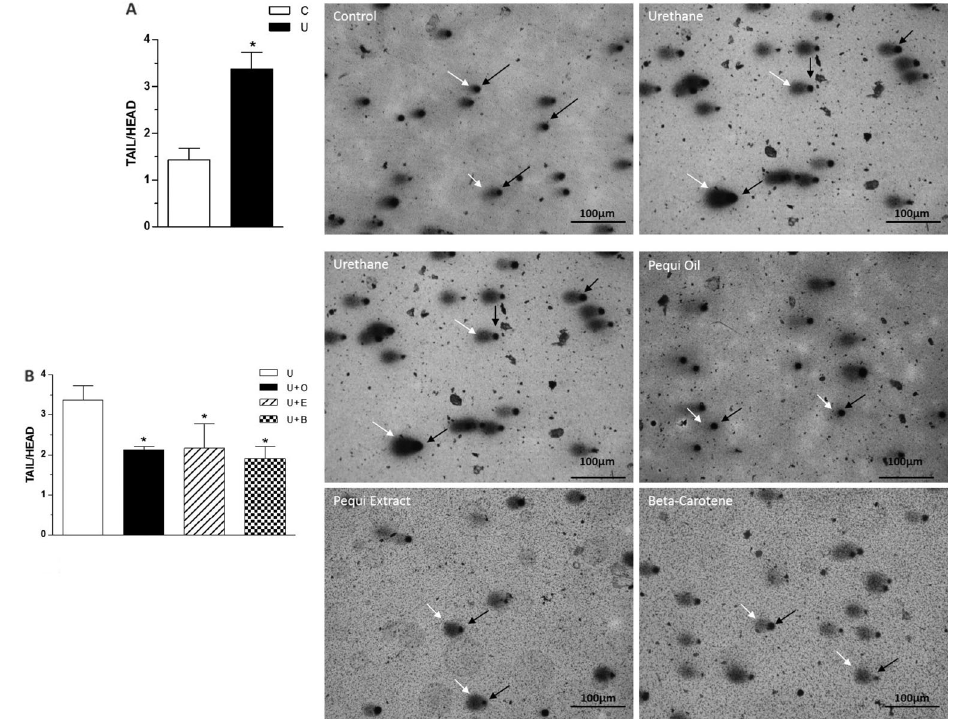
Figure 4. Oxidative damage to DNA in lung tissue specimens. A , Lung tissues from urethane-injected mice (U) showed higher DNA damage when compared to control mice (*P o 0.0001, t -test). The degree of DNA damage is illustrated in lung cells of control mice and urethane-injected mice (arrows). B , The ratios of tail/head as measured in the comet assay of supplemented mice (U + O: pequi oil group; U + E: pequi ethanolic extract group; U + B: beta-carotene group) show reduced DNA damage compared to urethane-injected mice (*P o 0.0001, ANOVA; arrows). Data are reported as means ± SD in urethane-injected and control mice (n=5) and urethane- injected and supplemented mice (n=10). Black arrows show the head and white arrows show the tail.